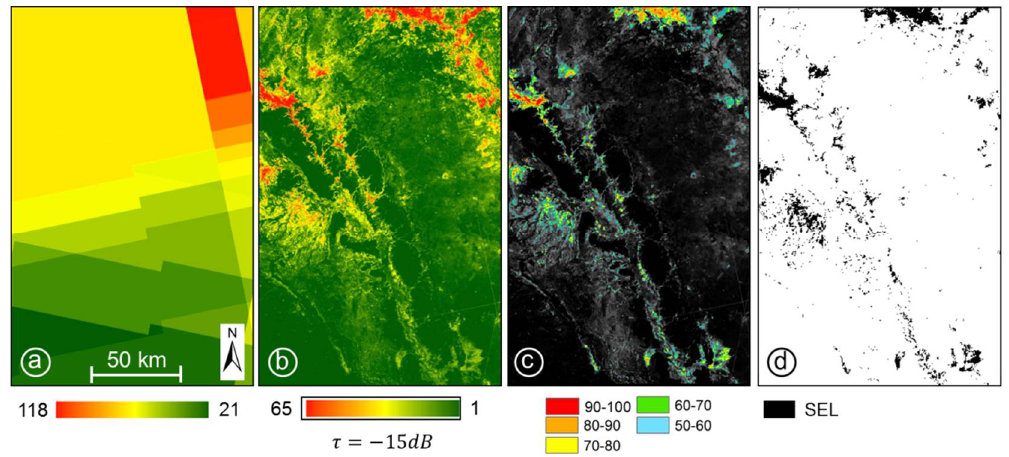
Figure 5. ( a ) Sentinel-1 acquisition frequency mask f (time period: 1 June 2014–31 May 2017); ( b ) absolute frequency f a ( τ < −15 dB); ( c ) relative frequency f r (grouped in 10% classes); ( d ) Sand Exclusion Layer (SEL) based on classes 50–100%.